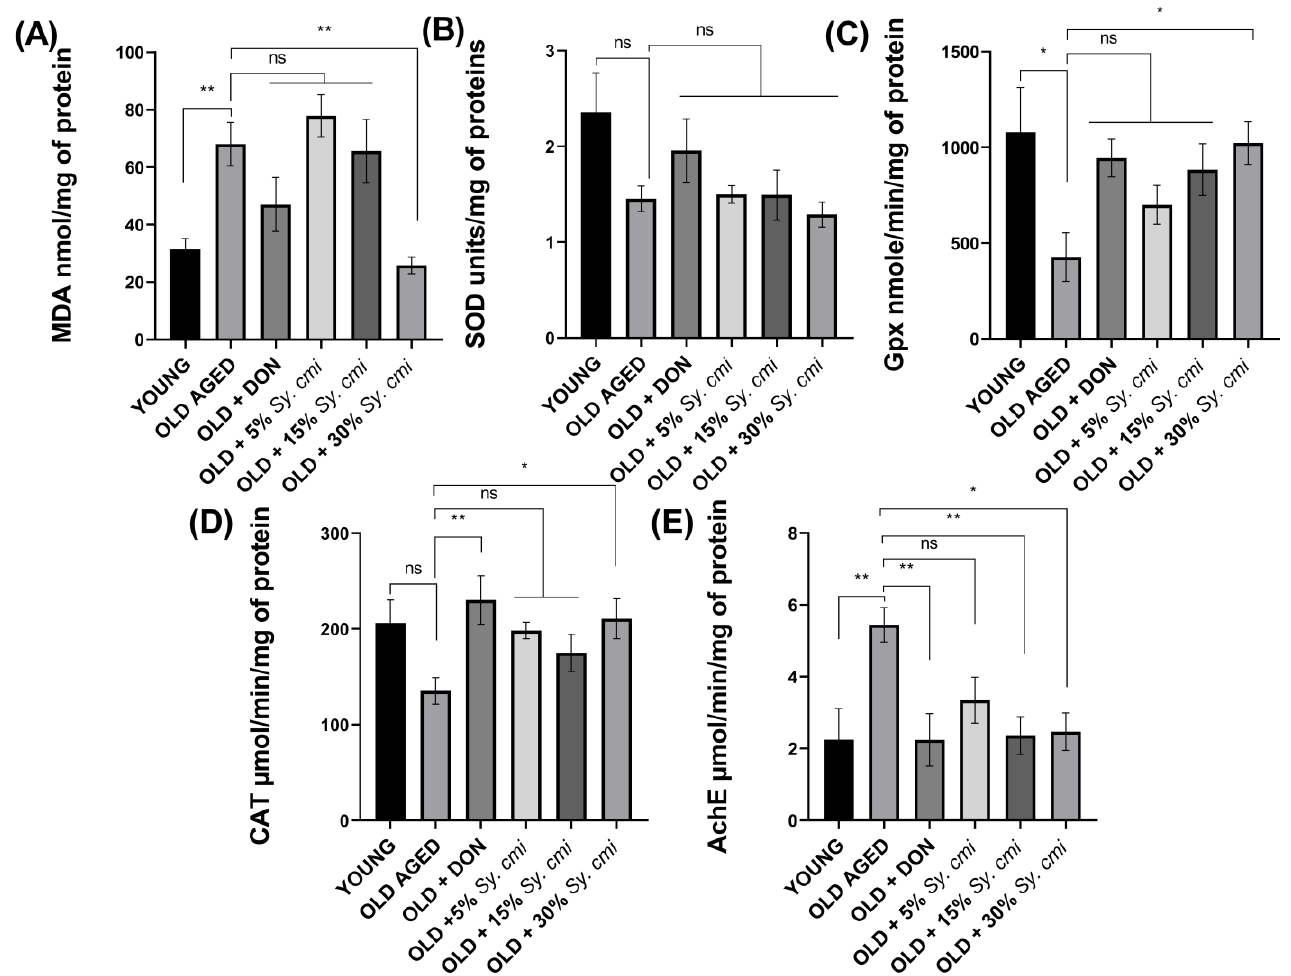
Figure 10. The dissected brains of mice ( n = 8) supplemented with 5, 15, and 30% dilutions of Sy. cmi for 16 months were tested for ( A ) malondialdehyde, ( B ) superoxide dismutase, ( C ) glutathione peroxidase, ( D ) catalase, and ( E ) acetylcholinesterase levels. The outcomes of all groups were compared with the aged control group and * p < 0.05, ** p < 0.01 were considered statistically significant while ns showed non-sgnificant outcomes for all data presented as mean ±